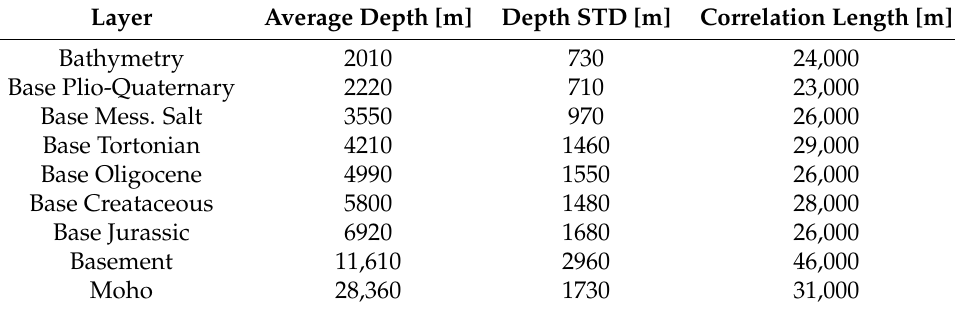
Table 1. Statistics of the simulated geological horizons. Layer Average Depth [m] Depth STD